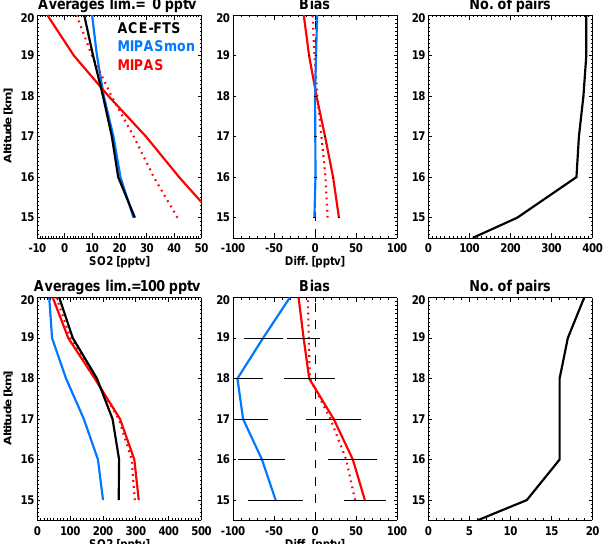
Figure 5. Same as top row in Fig. 4 but (1) only for MIPAS- mon and MIPAS, (2) separated in MIPAS phase 1 (top row) and phase 2 (bottom row) observation periods and (3) exclud-